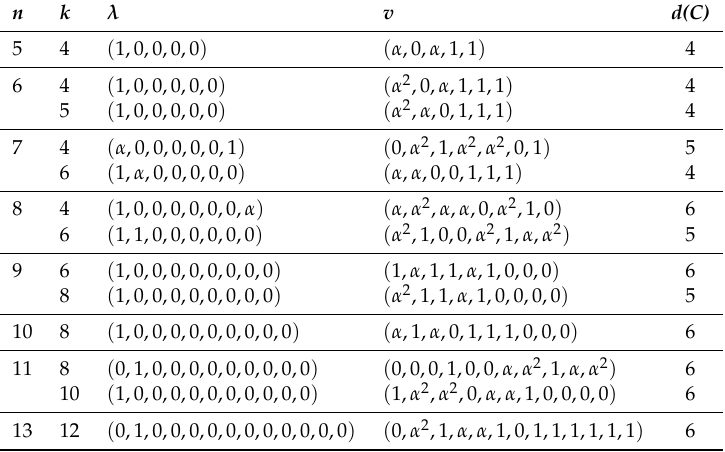
Table 2. Vector-circulant based ( n ,2 k ) 4 codes over F 4 = { 0,1, α , α 2 = 1 + α } generated by cir λ ( v )